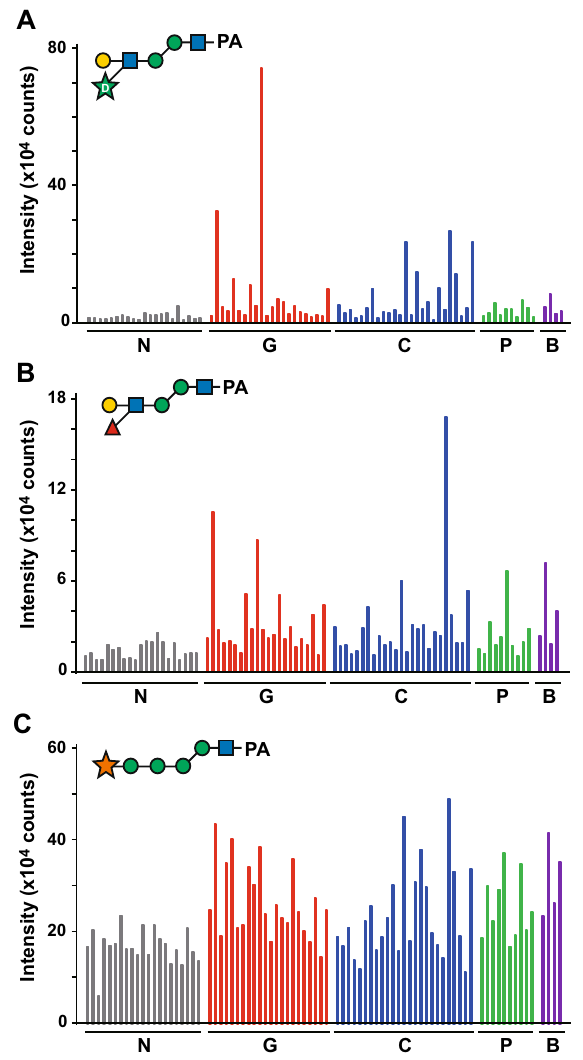
Figure 6. Quantification of the d-arabinose-containing glycan found in urine by SRM. The PA-glycan mixture from urine corresponding to 10 μg of creatinine was used for relative comparison of urinary free-glycan level. The peak area in the extracted ion chromatogram (XIC) of SRM transition was measured. The values of Q1 and Q3 used for measurements are shown in Supplementary Table S3. The glycan levels from urine of gastric cancer patients (G1-22), colorectal cancer patients (C1-25), pancreatic cancer patients (P1-10), bile duct cancer patients (B1-4) and normal controls (N1-21) are indicated by red, blue, green, purple and gray bars, respectively. ( A ), ( B ) and ( C ) show the level of d-arabinose-, fucose- containing N -glycan and xylose-containing oligomannoside,